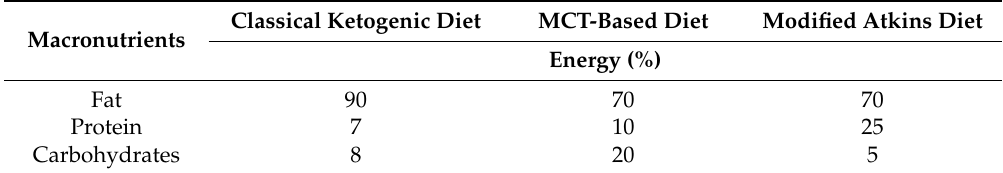
Table 1. Characteristics of ketogenic diets